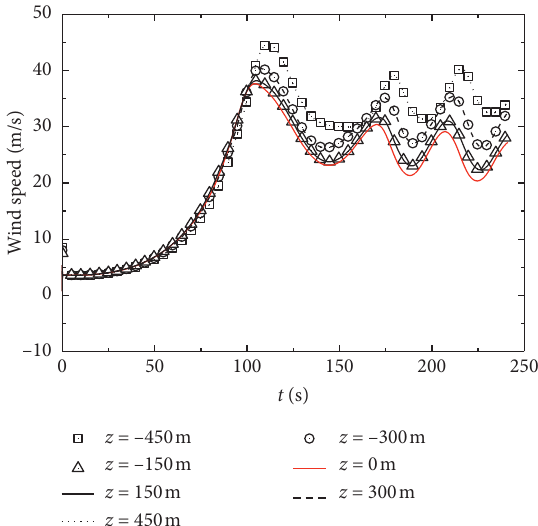
Figure 6: Time-history curves of horizontal wind speed in the gorge